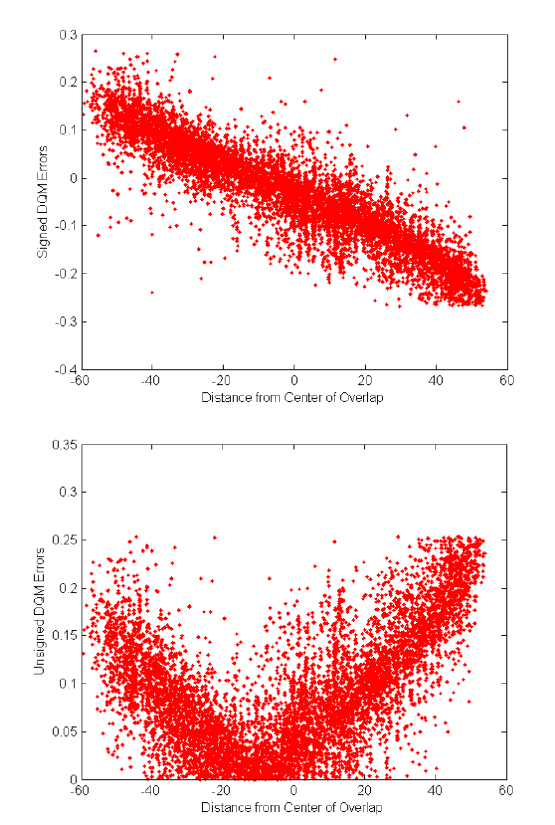
Figure 6 Visual representations of systematic errors in the swath data. The plots show DQM errors isolated from flat regions (slope < 5 degrees). 6(a) plots signed DQM Errors vs. Distance from the center of Overlap, while 6(b) plots Unsigned DQM errors vs. Distance from center of overlap.